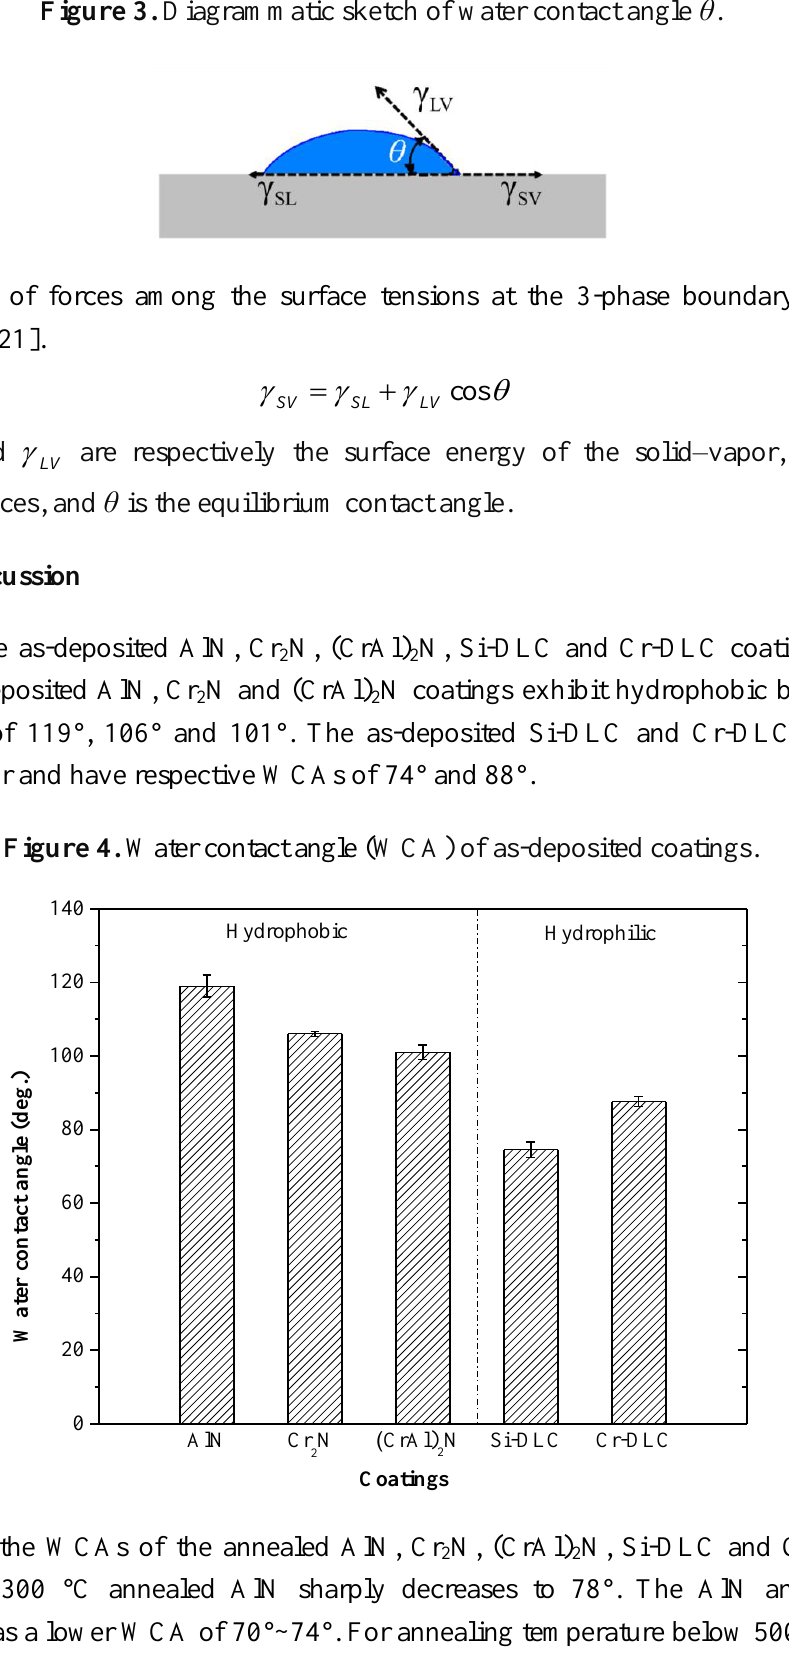
Figure 3. Diagrammatic sketch of water contact angle θ .